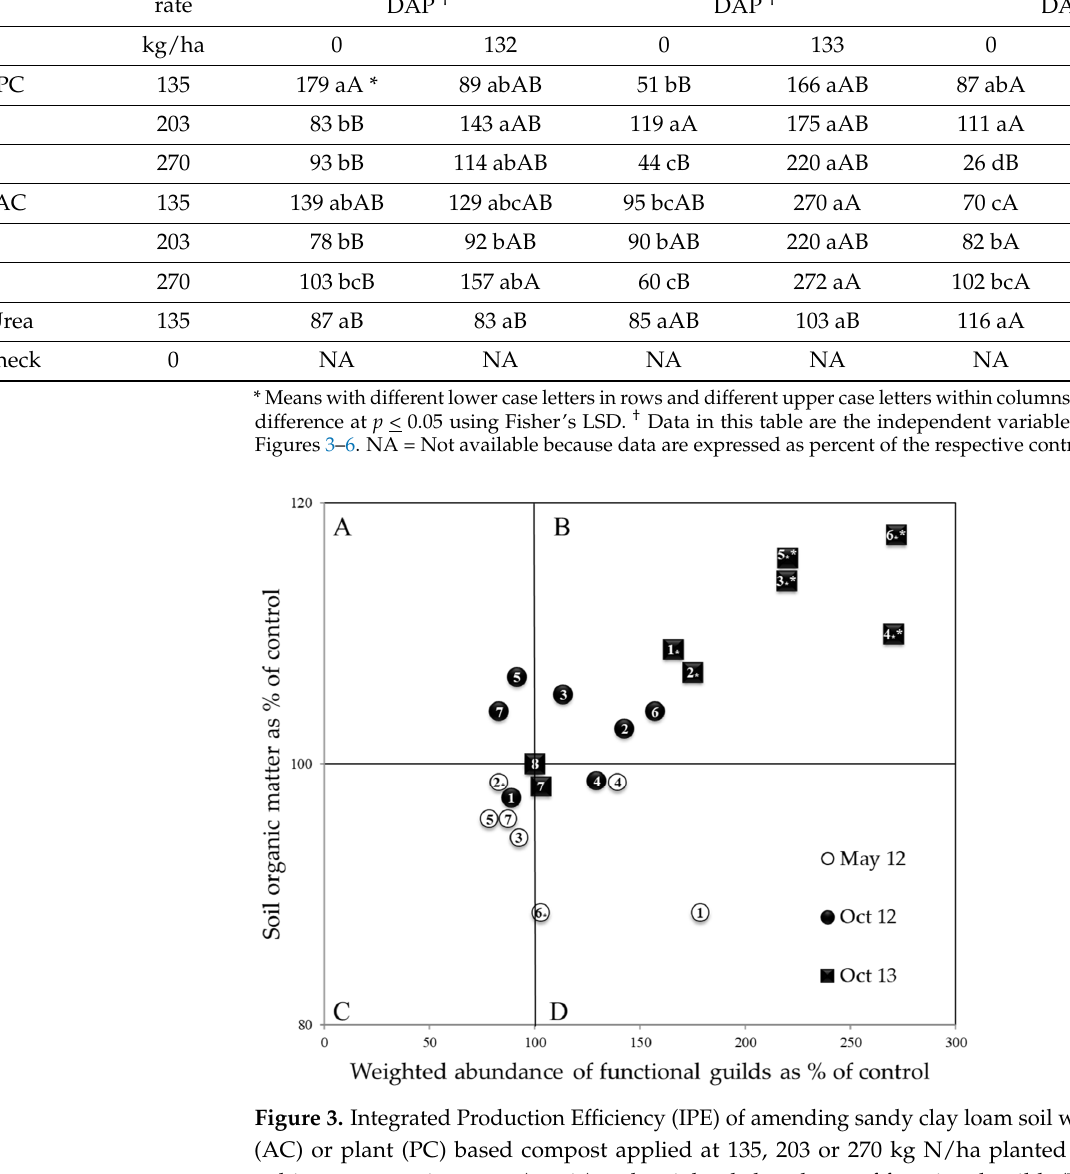
Table 1. Effects of amending sandy clay loam soil with either animal (AC) or plant (PC) based compost applied at 135, 203 or 270 kg N/ha planted with processing cultivar on weighted abundance of functional guilds (WAFG) as percent of untreated control at planting (0) and at harvest during 2012–2014 growing seasons. Untreated check and urea containing standard N rate of 135 kg N/ha served as controls. The harvest dates were 132 in 2012 and 133 DAP in 2013 and 2104.